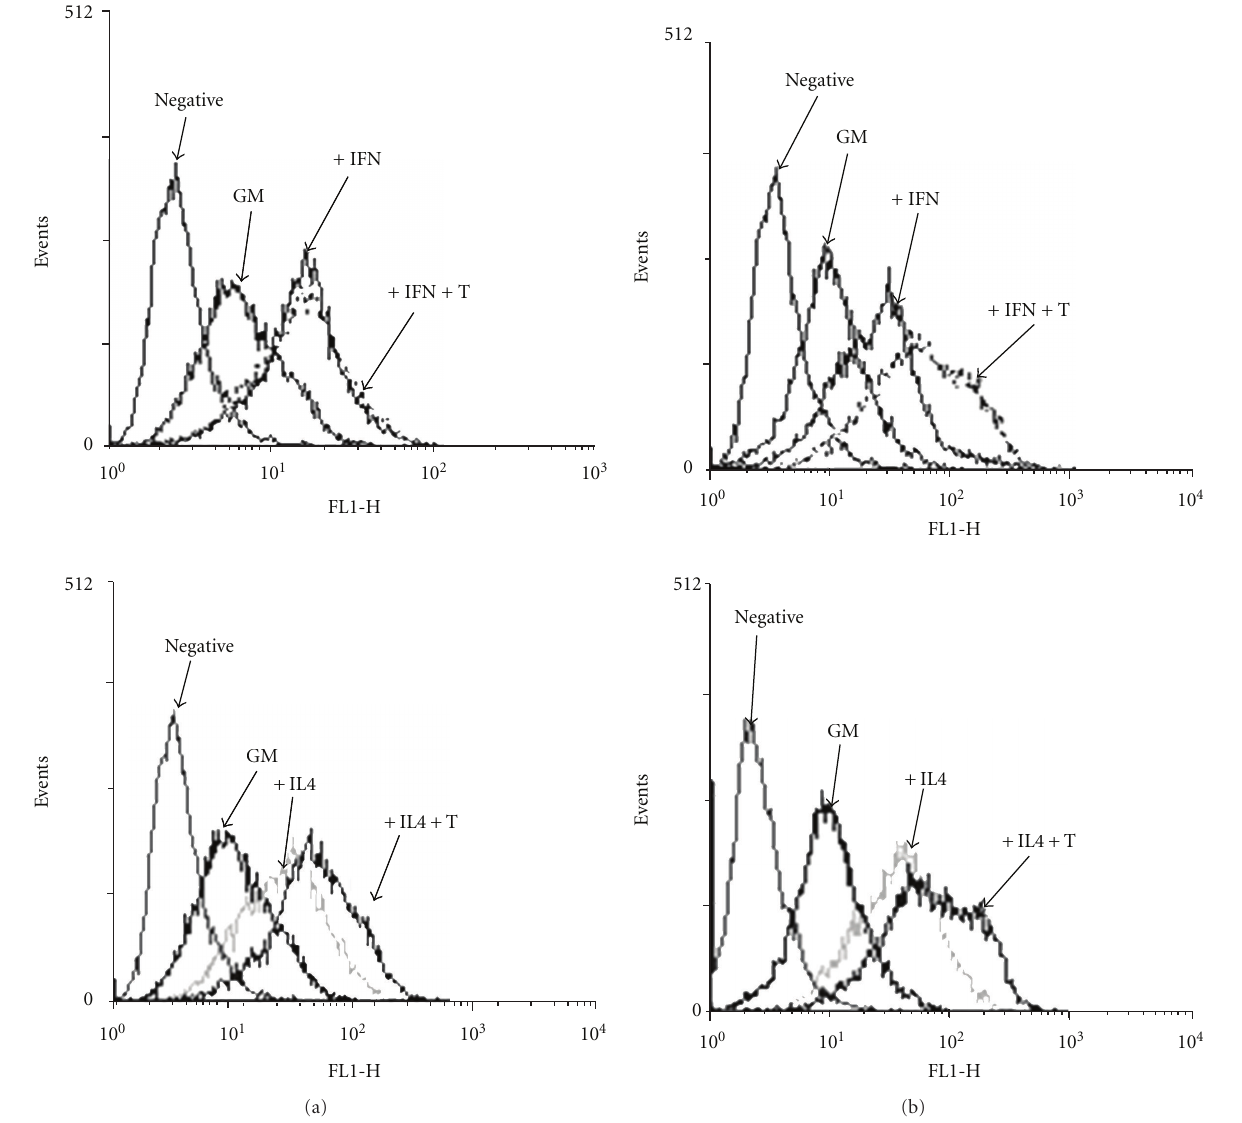
Figure 2: TNF- α promotes CD40 expression induced by IFN- γ after 48 hours of treatment. The histogram analysis of CD40 expression in MTHCs treated with either IFN- γ (2units/mL) or IFN- γ + TNF- α (broken line, IFN+T) is the representative results of FACS analysis from two separate experiments at 24 and 48 hours after treatment (upper panel). IL-4 and IL-4 + TNF- α (IL-4+T) treatments are shown in the lower panel. Negative and GM controls are the same as in Figure